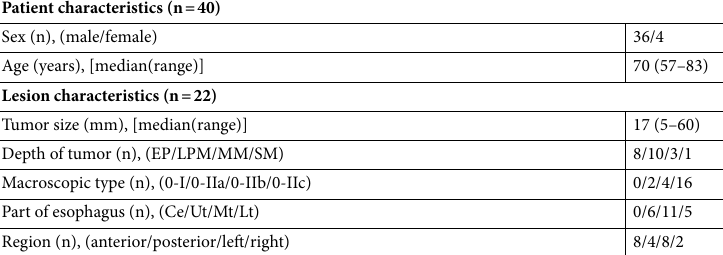
Table 2. Characteristics of the validation video sets (the high-speed validation video sets). EP: epithelium, LPM: lamina propria, MM: muscularis mucosae, SM: submucosa Ce: cervical esophagus, Ut: upper thoracic esophagus, Mt: middle thoracic esophagus, Lt: lower thoracic